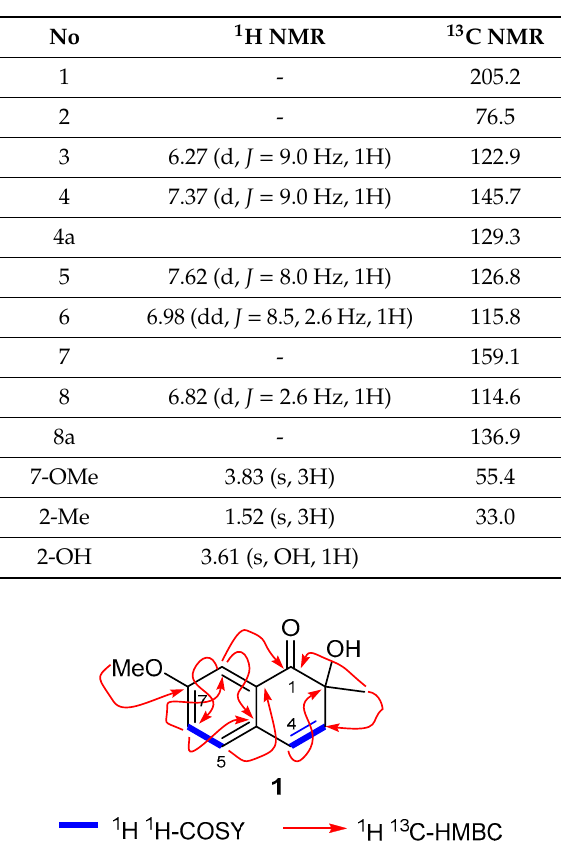
Table 1. 1 H NMR (400 MHz) and 13 C NMR (100 MHz) data of cichorin D ( 1 ) in CDCl 3 .